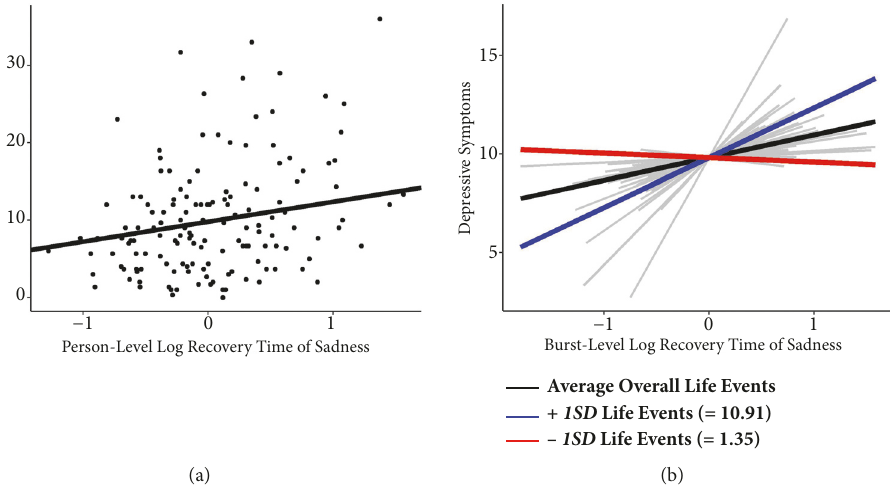
Figure 4: Model implied associations between log recovery time of sadness and depressive symptoms (CESD). (a) shows the between- personassociation: individuals with longer recovery time have higherlevel of depressive symptoms. (b) shows the prototypical within-person association (black line), the extent of between-person differences in the within-person association (gray lines), and how the within-person associationwas moderatedby levelof life events.Foran individual with low life events(-1 SD , red line)therewas nowithin-person association between recovery time and depressive symptoms, while for an individual with high life events (+1 SD , blue line), burst increases in recovery time were accompanied by more depressive